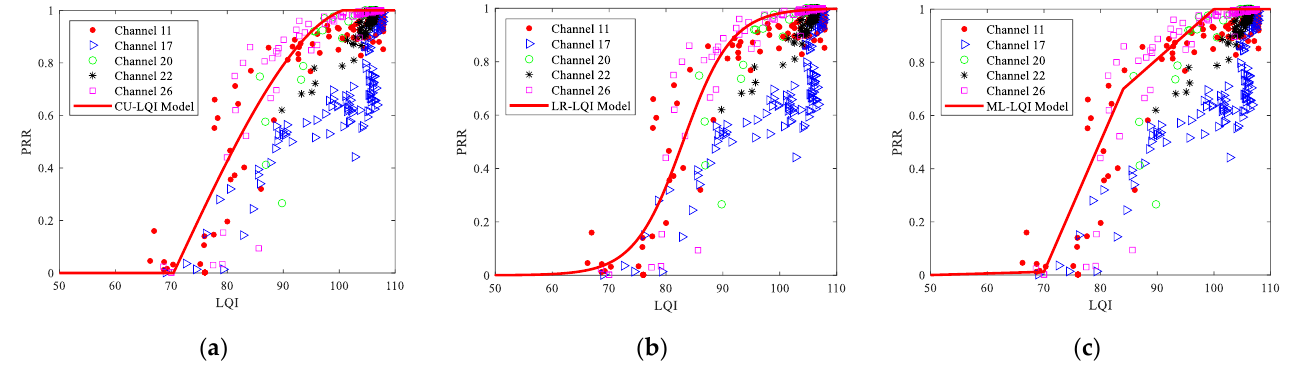
Figure 11. Measured and Estimated LQI and PRR under different channels: ( a ) The CU-LQI model; ( b ) The LR-LQI model; ( c ) The ML-LQI model. Next, the impact of channel changes on the models of LQI and PRR is analyzed. All the multi- segment linear model, cubic model, and logistic regression model of LQI and PRR were trained with the measured data under channel 26. The fitted parameters are shown in Table 5. With these parameters, the curves of these models of LQI and PRR under different channels can be obtained, as shown in Figure 11. It can be seen that the curves of these models are basically consistent with the measured data under channel 26. However, there are large differences between the estimated PRRs of these models and the measured PRRs under other channels, especially for channels with strong interference. When the interference level changes, these three models will be completely